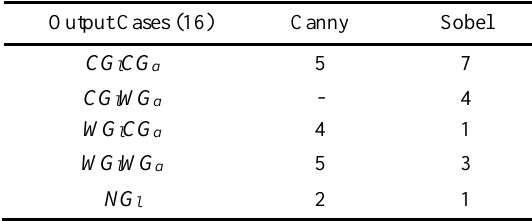
Table 5. Comparison of edge detectors for dissimilar